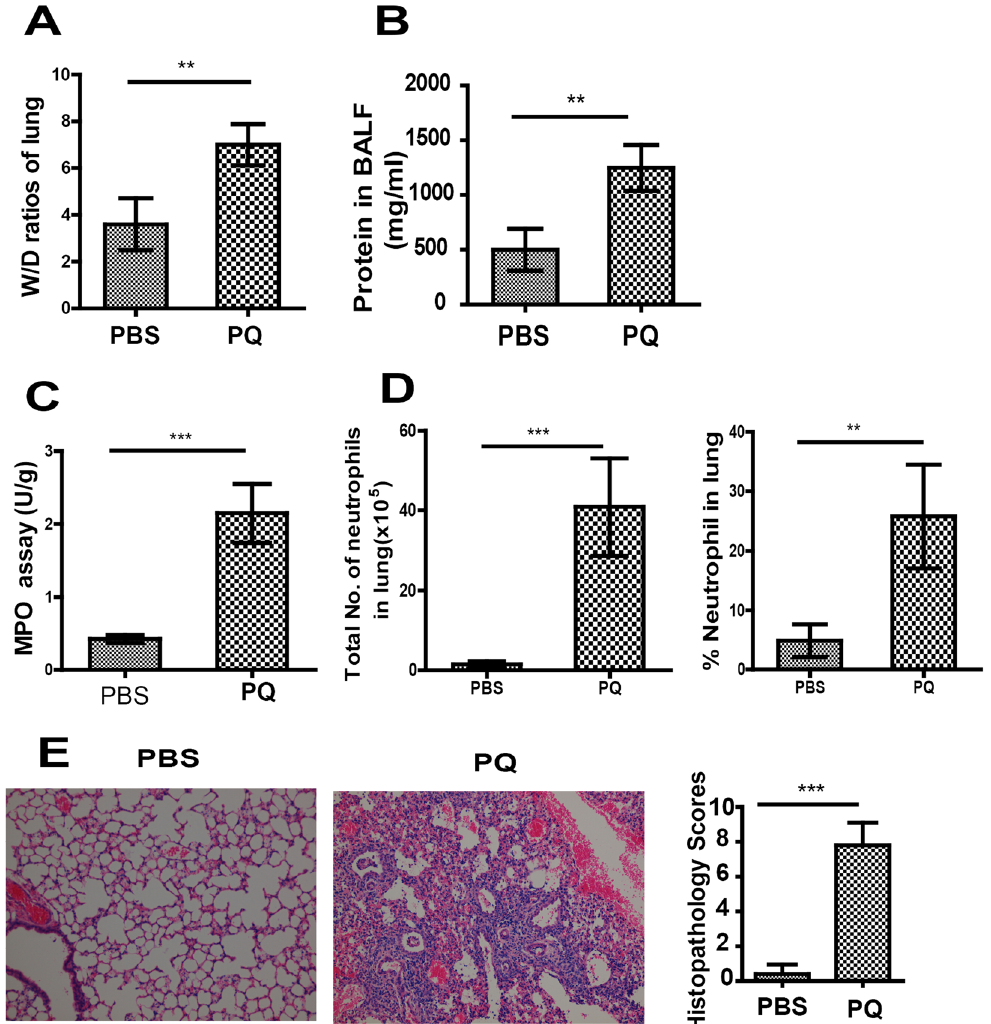
Figure 1. Paraquat (PQ) ingestion induces acute lung injury (ALI) and neutrophil infiltration into the lung. Mice were gavaged with PQ at 40 mg/kg (body weight; n = 15) or equal volumes of PBS as the vehicle control (n = 15). At 72 h after PQ challenge, the mice were sacrificed, and the lung tissue or bronchoalveolar lavage fluid (BALF) was collected for analyzing the following parameters indicating lung injury. ( A–D ) The wet to dry (W/D) ratio of the lung ( A ), the total protein concentration (mg/ml) in BALF ( B ), the MPO activity with the lung tissues ( C ), the total number and percentage of lung-infiltrating neutrophils ( D ) were significantly elevated in PQ-challenged mice, compared to PBS-challenged control mice. ( E ) Hematoxylin and Eosin (H & E) staining of the lung tissues (200 × ) presented a higher histopathology score in PQ-challenged mice. All data are presented as mean ± SD for all mice in each group and compared between the PQ- and PBS-challenged mice. ** P < 0.01, *** P < 0.005, compared to PBS-challenged